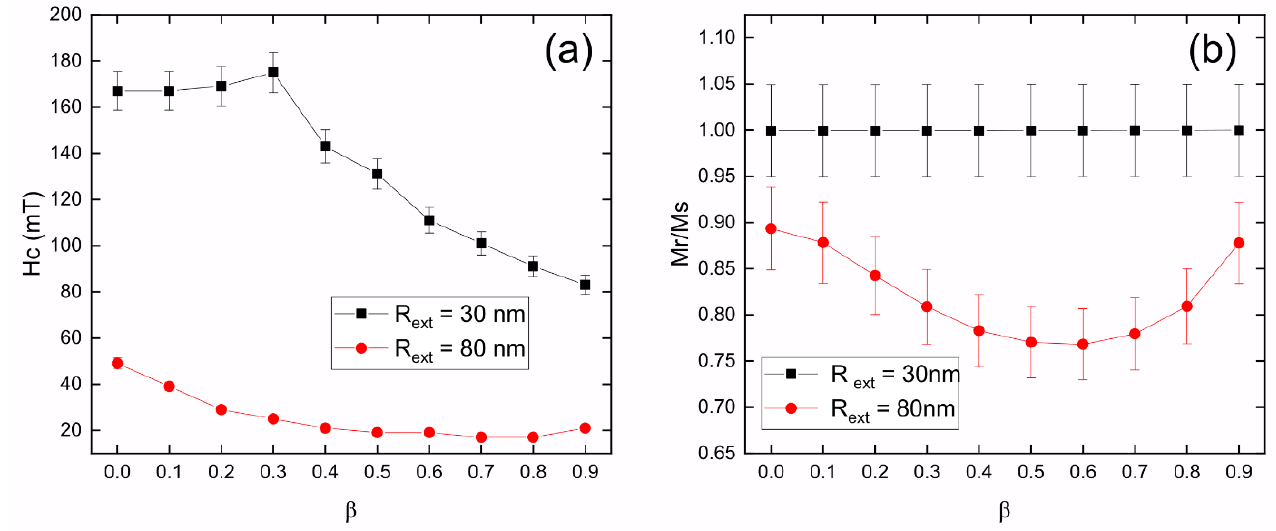
Figure 3. ( a ) Coercivity and ( b ) normalized remanence for 1000 nm long Fe 3 O 4 nanotubes with external radius 30 nm (black squares) and 80 nm (red circles), as a function of β , when the external magnetic field is applied along the z -axis. We considered an error of 5%.